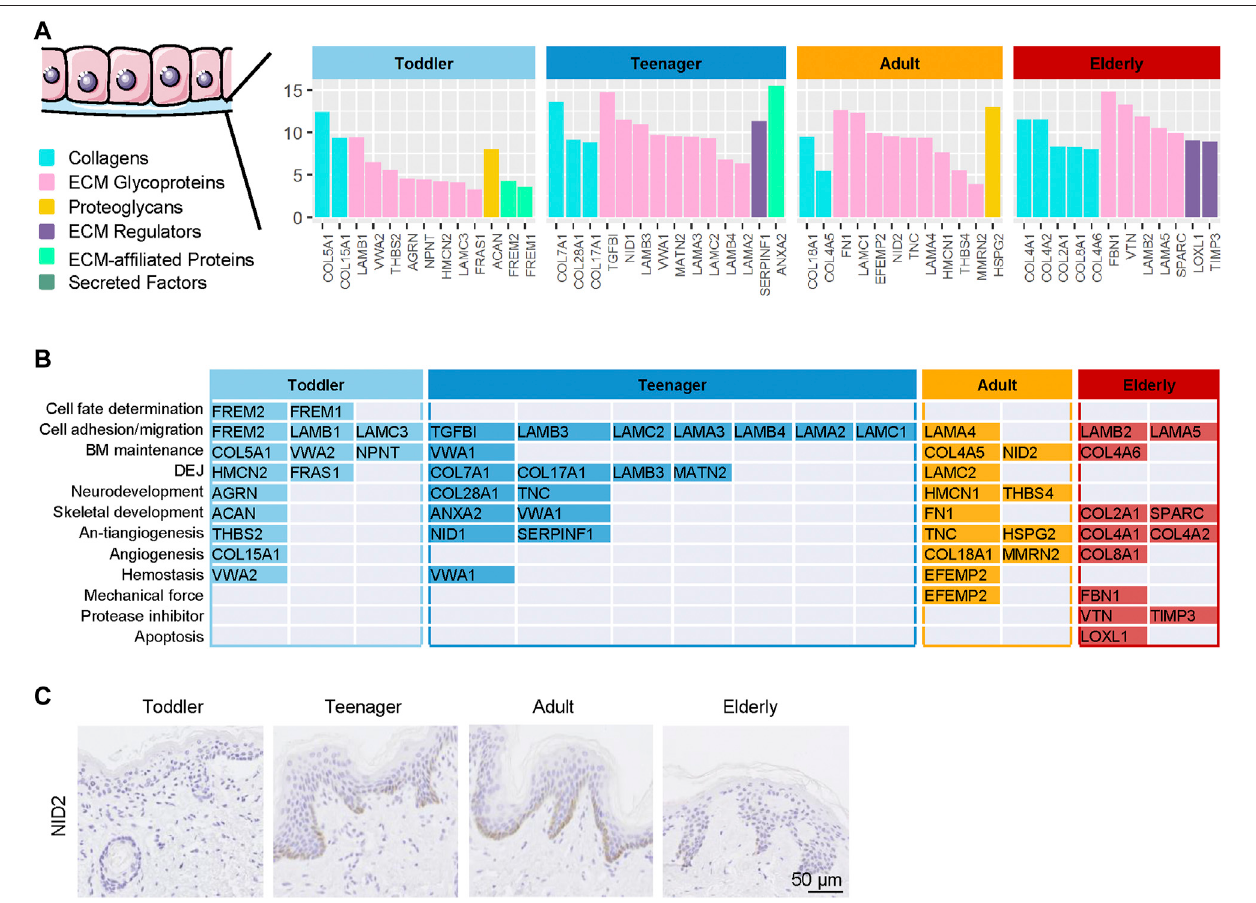
FIGURE 4 | | Highly expressed basement membrane (BM) proteins in the six ECM components in the human skin dermis from four ages (toddler, teenager, adult, and elderly). (A) Six types of ECM proteins of BM (collagens, ECM glycoproteins, proteoglycans, ECM regulators, ECM-af fi liated proteins, and secreted factors) expressed at four ages (toddler, teenager, adult, and elderly). (B) Functional analysis of BM located ECM from four ages (toddler, teenager, adult, and elderly). (C) Immunohistochemistry of NID2 in the skin tissues of toddler, teenager, adult, and elderly (scale bar represents 50 μ m).